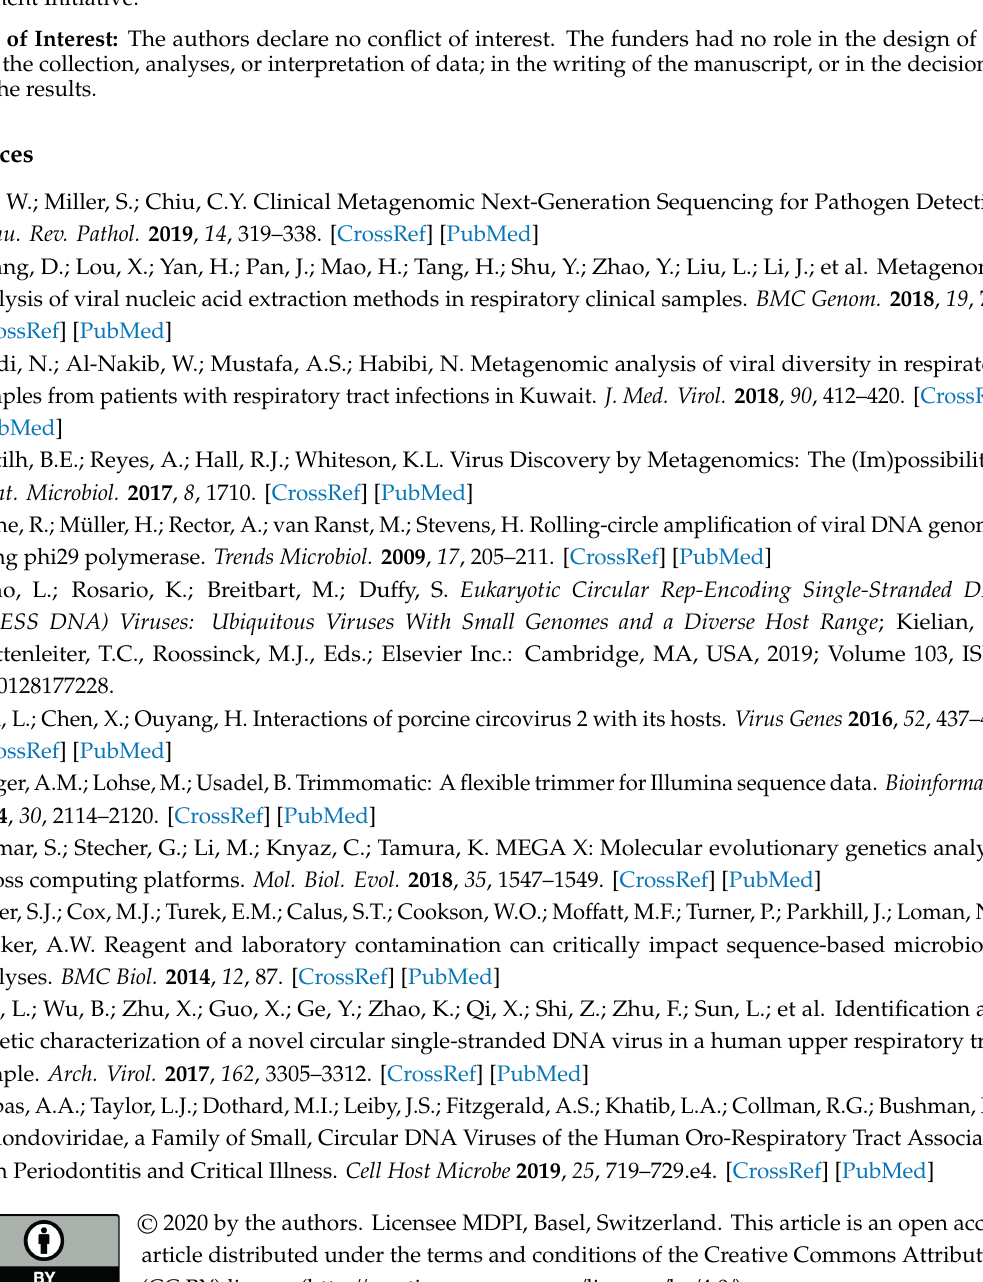
Table S1: Primer pairs used in this